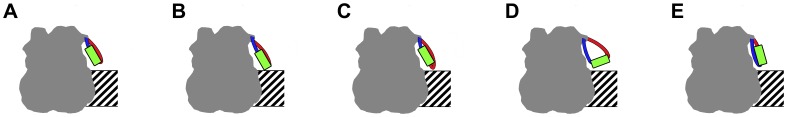
Proposed vector modifications for optimizing MPER presentation at the Ad hexon HVR2 site.(A) Schematic representation of the MPER insertion incorporated within the Ad-HVR2-GP41-L15 vector. The hexon capsid protein (gray) is shown together with the N-terminal 3aa linker (blue), the MPER peptide (green), and the C-terminal 10aa linker (red). The protein-protein interface between hexons in the Ad capsid is represented by a hashed region. (B-E) Based on the structural analysis of the Ad-HVR2-GP41-L15 vector, four possible modifications are proposed which include (B) extending the N-terminal linker by 3aa, (C) extending the C-terminal linker by 4aa, (D) extending both the N- and C-terminal linkers by 2aa, and (E) swapping the N- and C- terminal linkers.